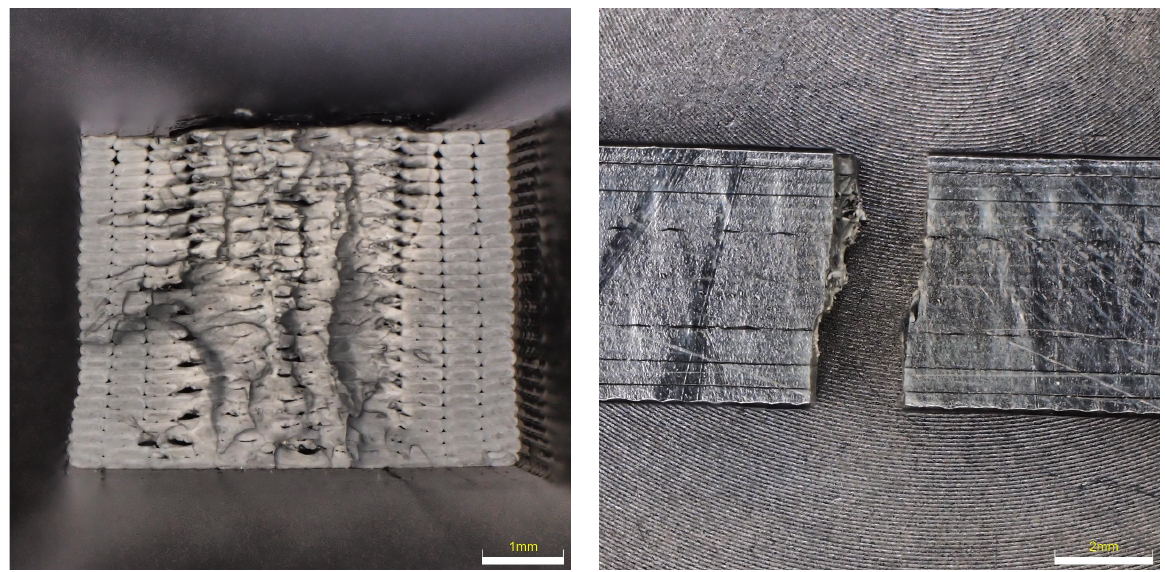
Figure 15. Character of fracture after tensile testing for ASA material.